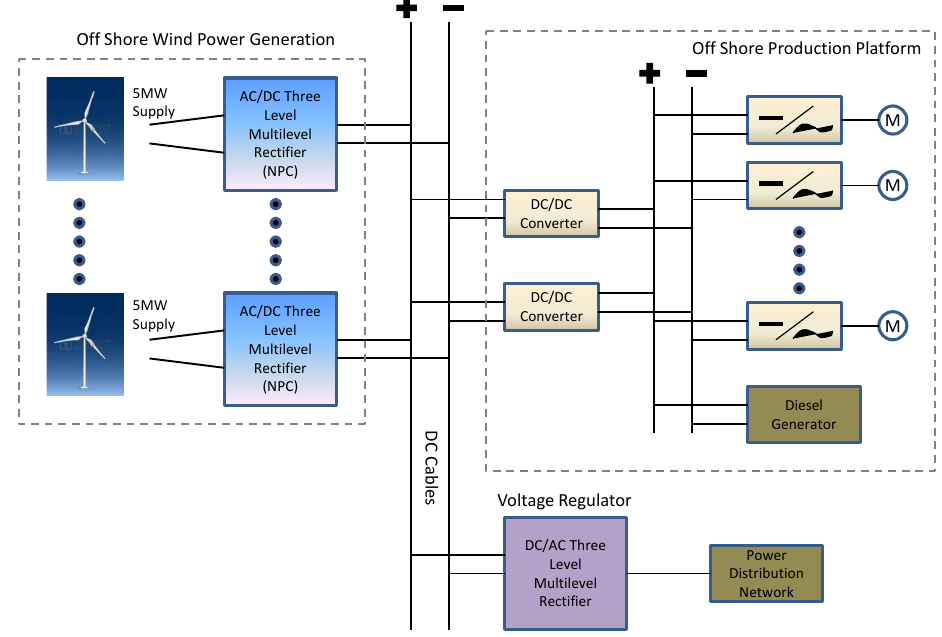
Figure 1. Offshore production platform with offshore wind power